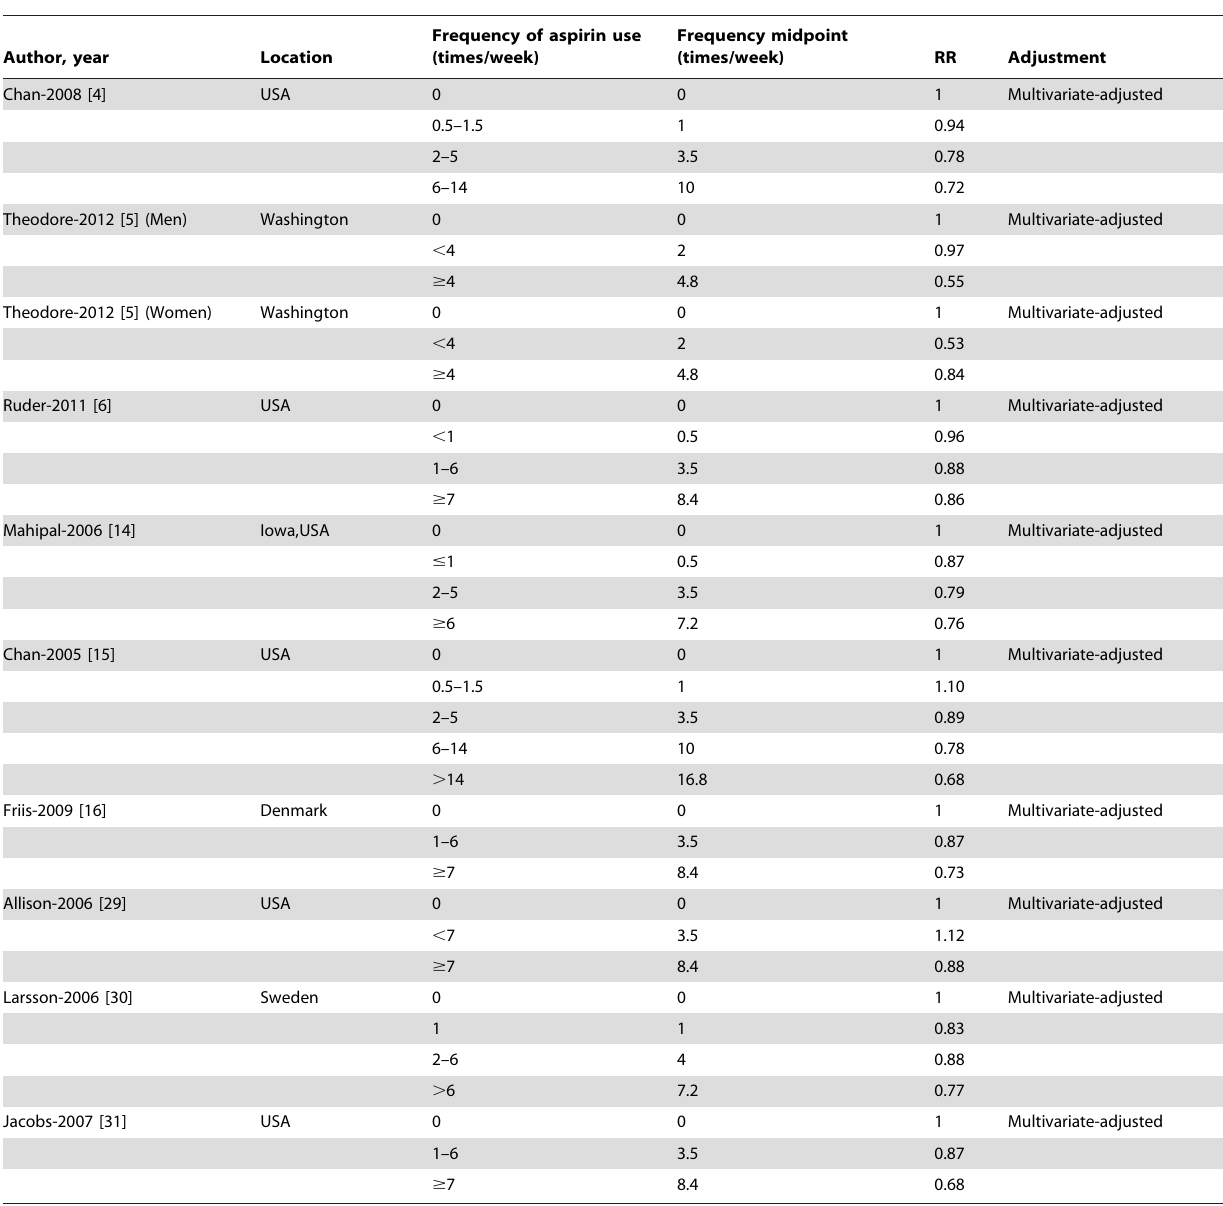
Table 2. Epidemiological studies of Frequency of aspirin use (times/week) and colorectal